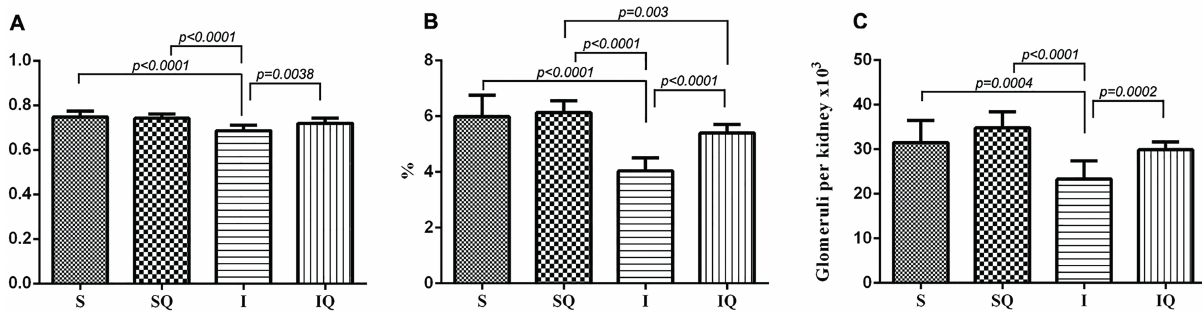
Figure 2 - Quantitative results of kidneys from group submitted to sham surgery (S), group sham treated with quercetin (SQ), group submitted to 60 minutes of renal warm ischemia (I), and group subjected to warm ischemia and treated with quercetin